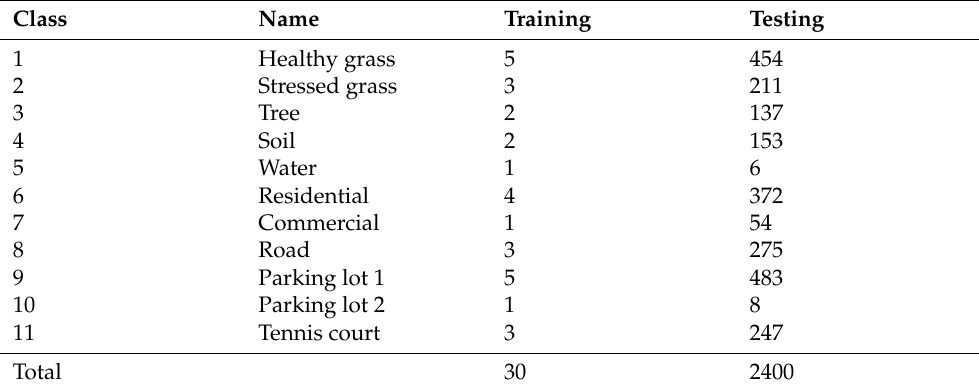
Figure 6. Salinas image: ( A ) composite color image and ( B ) ground truth; estimation map obtained by ( C ) SVM; ( D ) SRC; ( E ) JSRC; ( F ) NLW-JSRC; ( G ) SP-JSRC; ( H ) SNLW-JSRC. Table 7. Class-based numbers of training and testing samples for